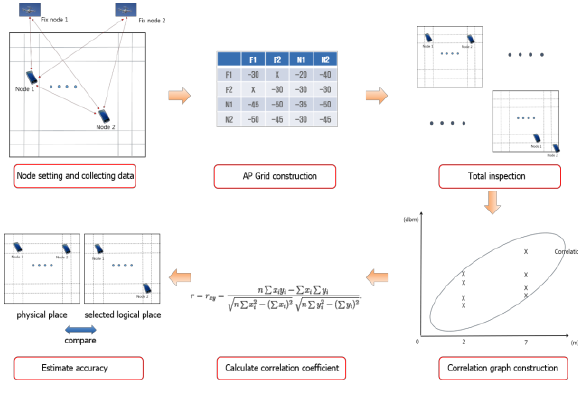
Figure 2. 2D positioning process by